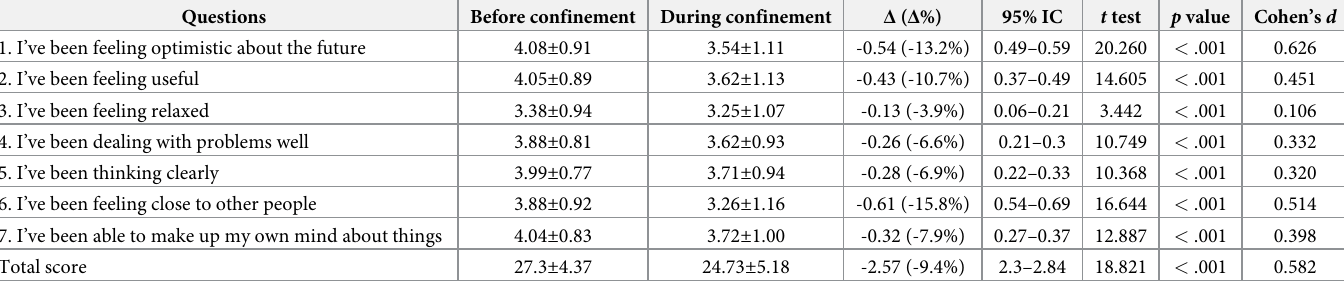
Table 2. Responses to the Short Warwick-Edinburgh Mental Wellbeing Scale before and during home confinement. Questions